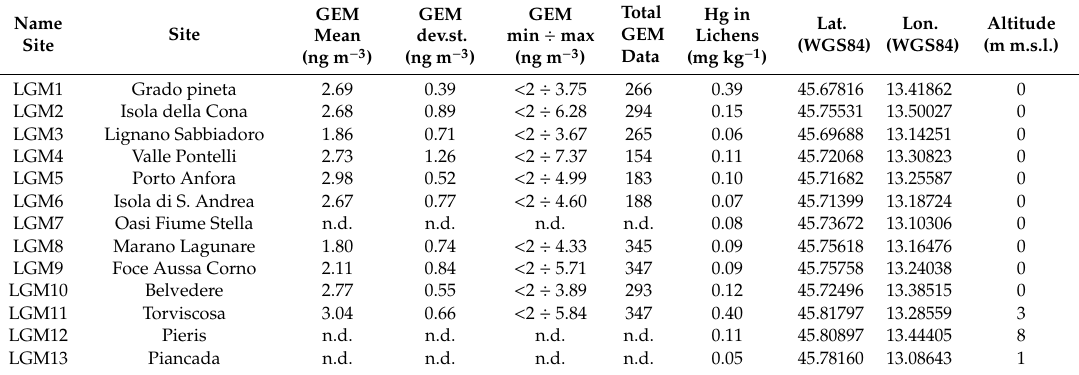
Table 1. Basic univariate statistics of the gaseous elemental mercury (GEM) dataset and Hg content in lichens grouped by sampling sites. n.d. = not determined. LGM is the abbreviation of Grado and Marano